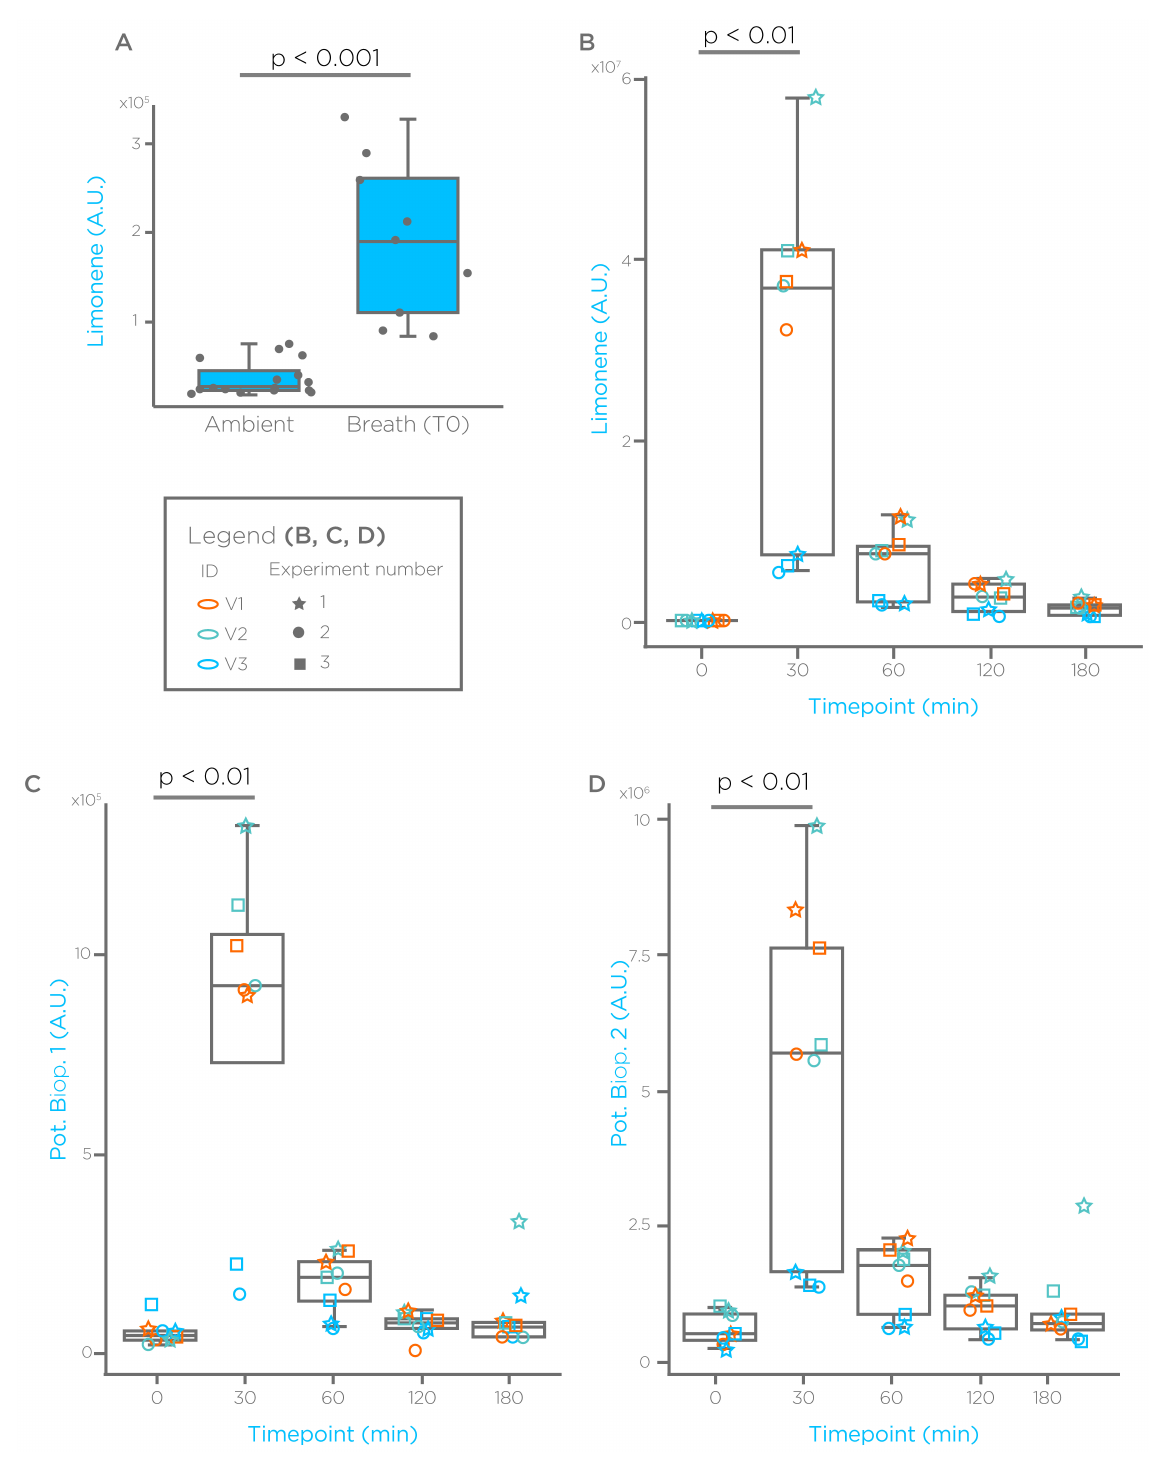
Figure 1. Limonene breath profile in healthy subjects before and after oral administration. ( A ) Breath limonene levels in 3 healthy subjects measured in triplicate after ≥ 10 h fasting and compared to ambient. ( B ) Breath limonene levels measured before and after oral administration at the indicated time points. Limonene ingestion induces a spike in breath after 30 min followed by a progressive reduction toward baseline levels. ( C , D ) Spectral features showing a limonene washout-like time course, which could be potential bioproducts (Pot. Biop.). A.U. = arbitrary